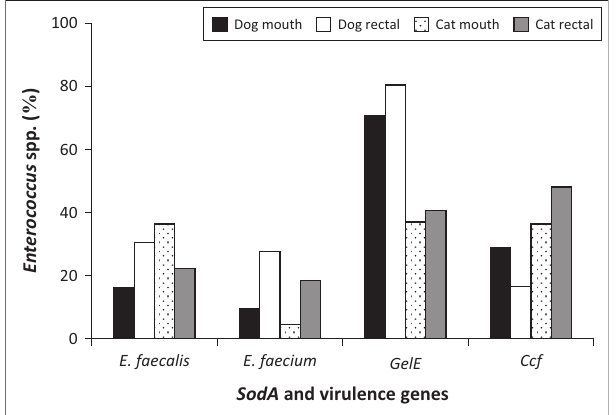
FIGURE 5: Prevalence of Enterococcus faecalis , Enterococcus faecium and virulence genes gelE and ccf in